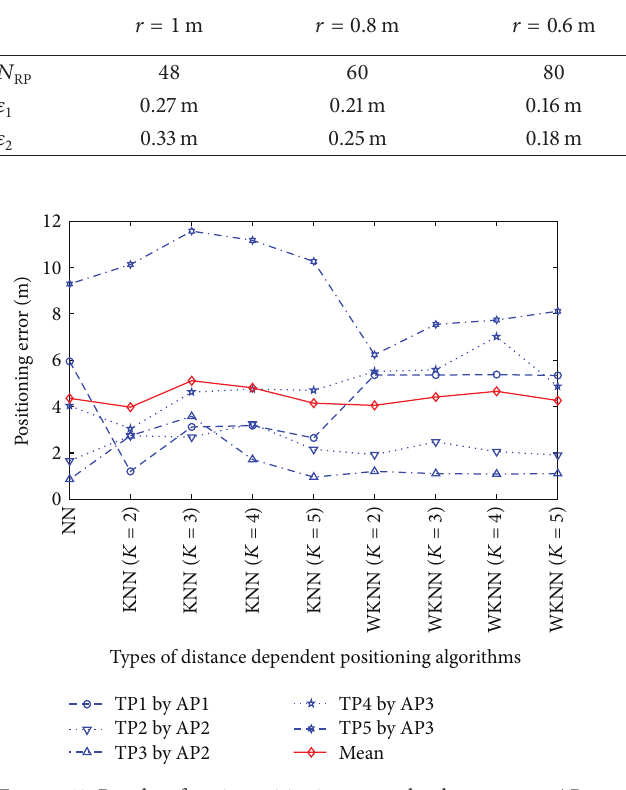
Figure 12: Results of static positioning errors by the strongest AP.